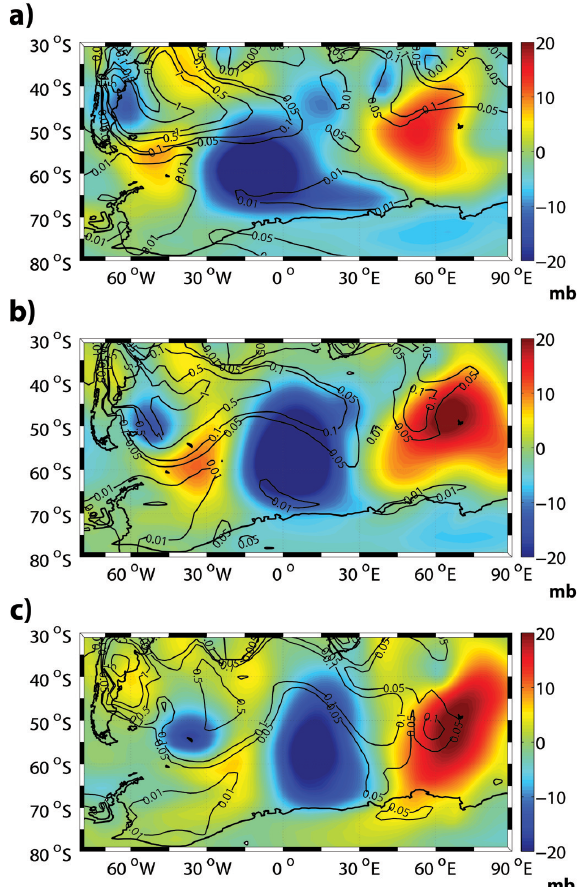
Fig. 2. GEOS-Chem-predicted daily dust burden (gm − 2 ) (contour lines) and sea level pressure anomalies (SLPAs) (mb) over the SAO for (a) 23 January, (b) 24 January, and (c) 25 January 2009. Cold colors indicate negative SLPA (low pressure systems) and warm colors display high pressure